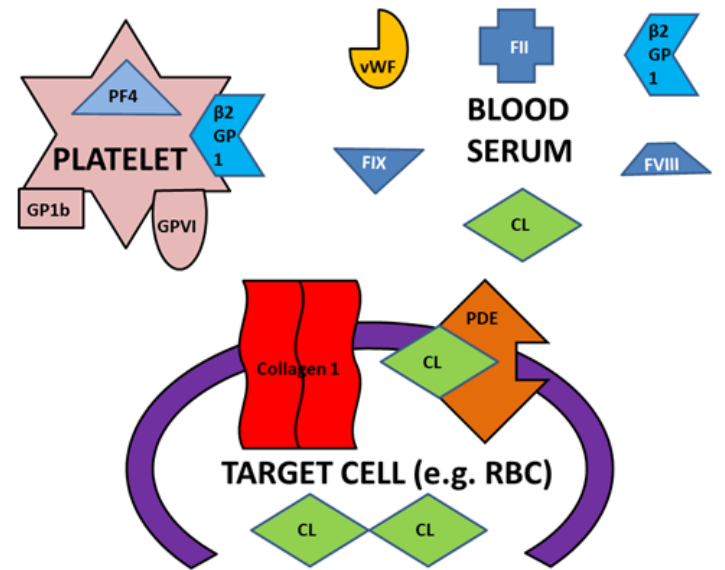
Figure 18. Some of the key blood proteins that were the focus of the present study and their rela- tionships to platelets, red blood cells (RBC) and blood serum components. β2GPI = β2glycoprotein1; PF4 = platelet factor 4; CL = cardiolipin; vWF = von Willebrand Factor; PDE = phosphodiesterase; F2 = blood coagulation factor II (prothromgin); FVIII = blood coagulation factor VIII; FIX = blood coagulation factor IX; GP1b = platelet glycopro-tein 1b; GPVI = platelet glycoprotein VI.